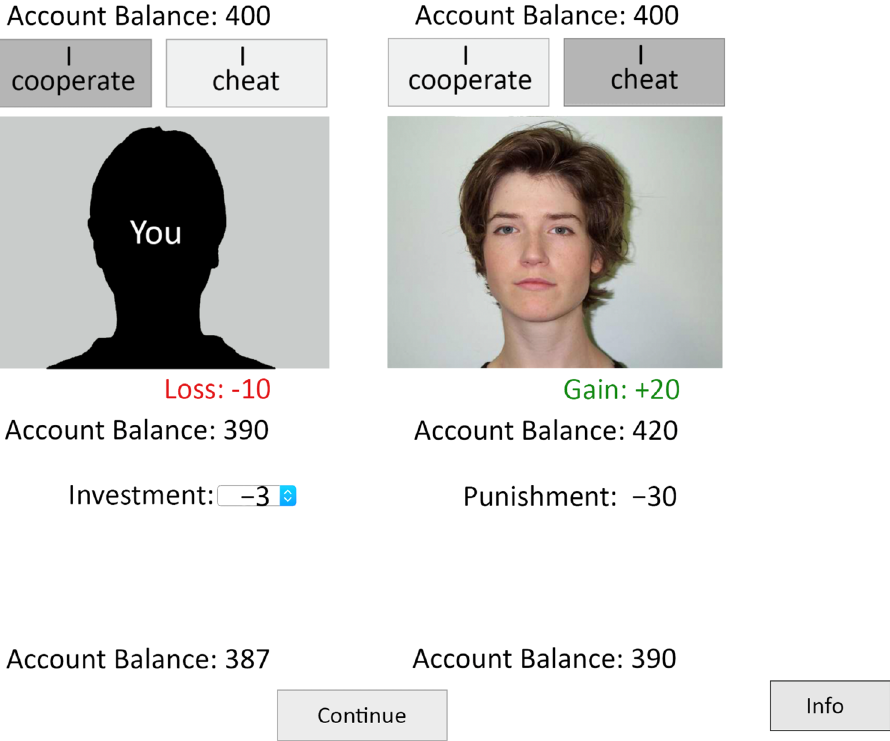
Figure 2. A screenshot of the simultaneous Prisoner’s Dilemma game with the costly punishment option used in Experiment 1. Depending on the framing condition, the grey buttons above the pictures displayed either the moral labels “I cooperate” and “I cheat” or the letters “A” and “B”. In the example trial displayed here, the participant cooperated while the partner cheated. The participant then chose to punish the partner by investing 3 cents to reduce the partner’s account balance by 30 cents. The facial photographs on the right side (one unique photograph for each partner) were taken from the Center for Vital Longevity Face Database 46